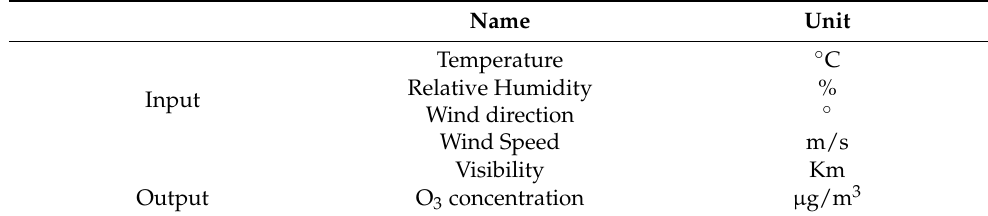
Table 1. Specific input and output information of the model.